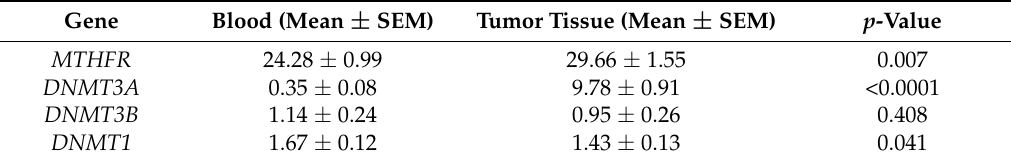
Methylation levels (%) of the studied genes in blood and tumor tissue of total thymoma-associated MG (TAMG) patients ( n = 69). Blood and tumor tissues were taken from the same donors, and the p -value refers to a t -test for paired